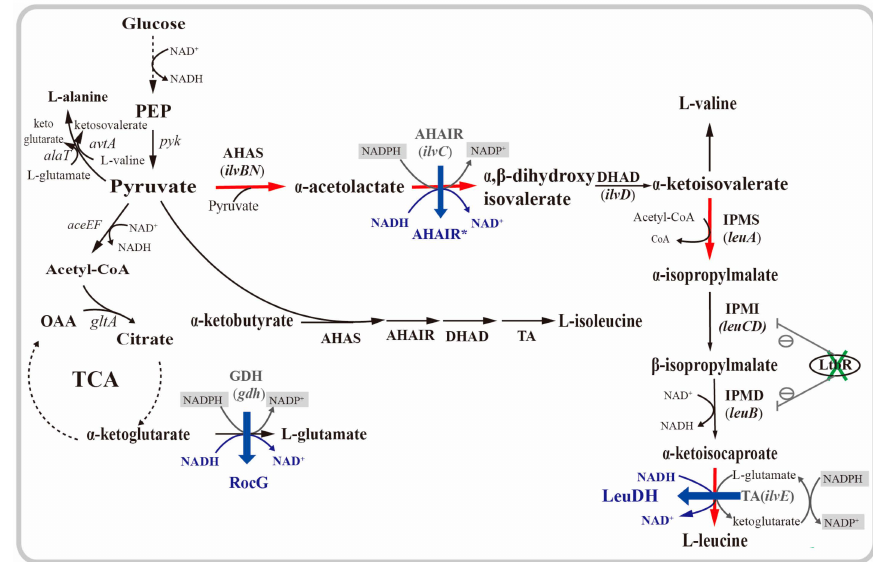
Figure 1. The l -leucine biosynthesis pathway of Corynebacterium glutamicum and the metabolic engineering steps performed in this study. Enzymes and corresponding genes are shown. An encircled minus indicates repression of gene expression (solid lines). Deletion of the gene encoding LtbR is indicated by green “ × ”. Red thick arrows indicate increased metabolic fluxes. Introduction of enzymatic reactions are highlighted in blue. NADPH and NADP + are highlighted in